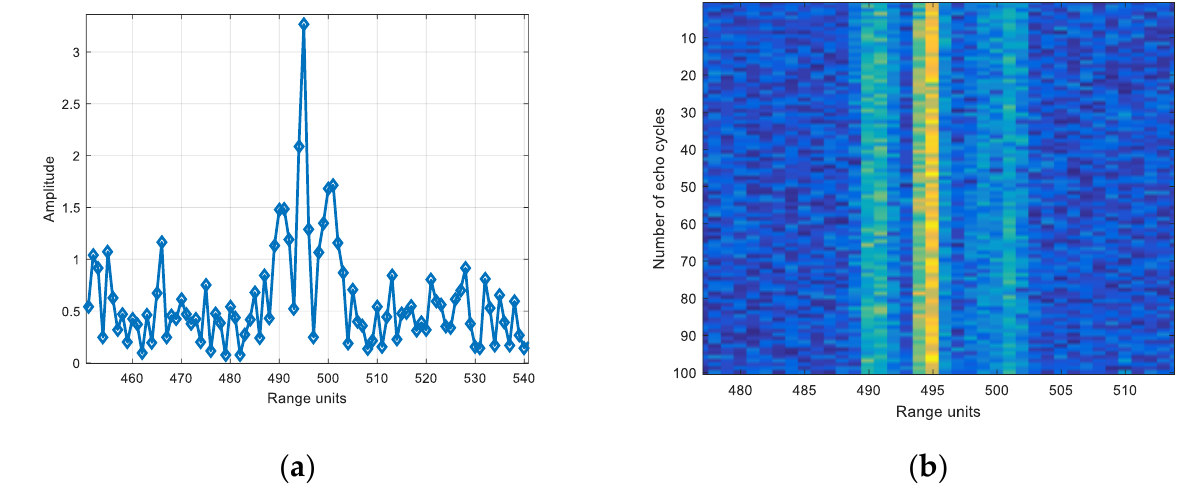
Figure 34. ( a ) Single frame and ( b ) 100 cycles echo diagrams with SNR of 12 dB in wideband.